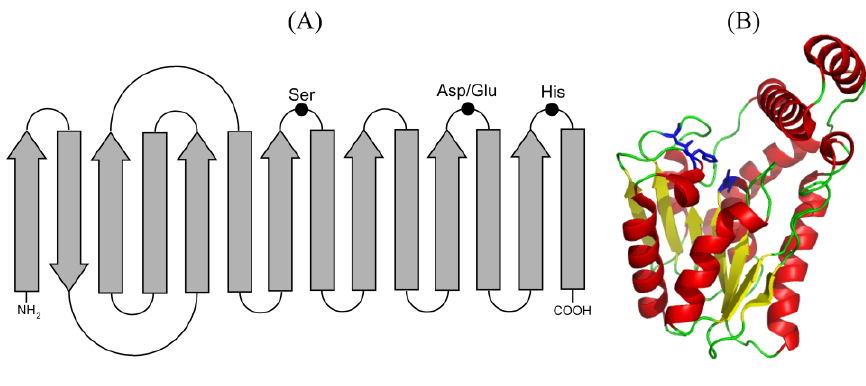
Figure 2. ( A ) Representation of the secondary structure of the α/β hydrolase fold showing the residues involved in catalysis. α helices and β strands are shown as arrows and boxes, respectively, black dots represent the residues of the catalytic triad. ( B ) Crystallographic structure of the carboxylesterase Est30 from Geobacillus stearothermophilus (PDB ID:1TQH) showing a modified α/β hydrolase core with a seven-stranded β sheet and a cap domain comprising three alpha helices. The ribbon diagram is colored yellow for β strands, red for α helices and green for loops. Residues of catalytic triad are shown as sticks in